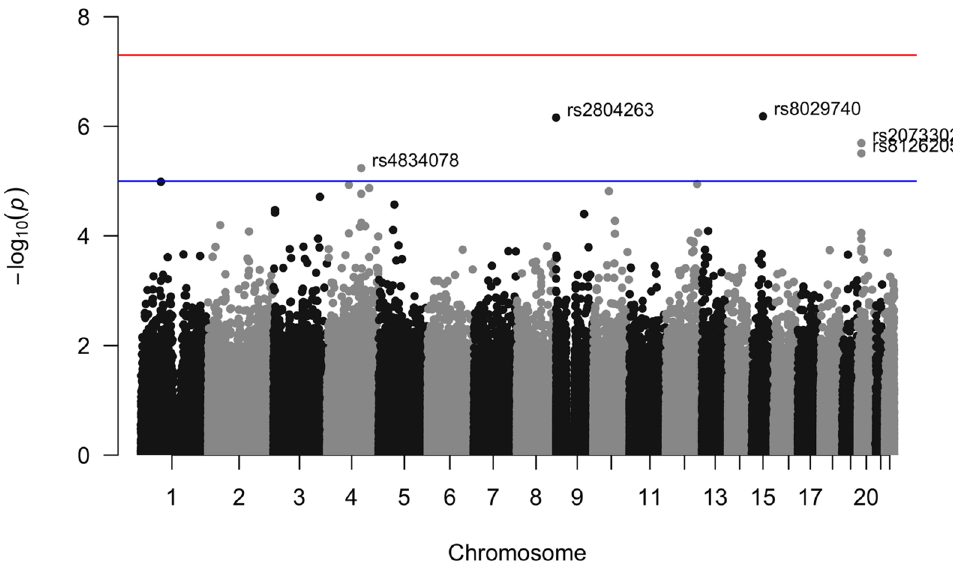
Fig 3. Manhattan plot of sibling variation in height among FHS 3rd generation sibling pairs. Results for the pairwise sibling standard deviation in height regressed against the sibling-pair minor count of alleles with controls for sex of sibship, mean age of siblings, age difference of siblings, sibling mean height, parental genotype.